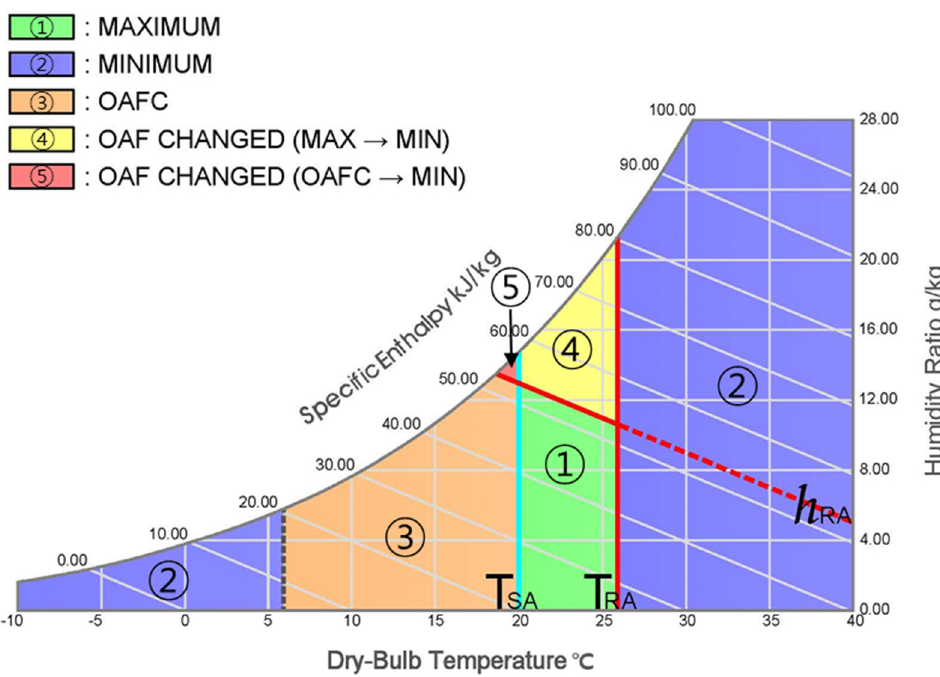
Figure 4. Differential dry-bulb temperature and enthalpy control method.